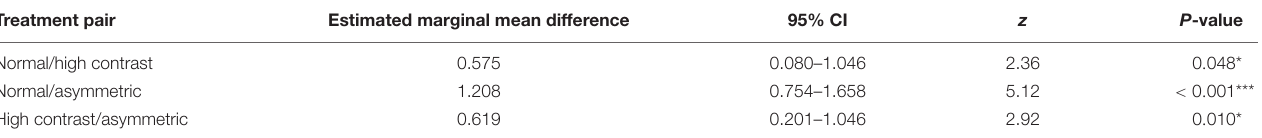
TABLE 4 | Pairwise comparisons of the marginal mean of proportions observed by a group of naïve bees for each treatment level during the learning tests. Treatment